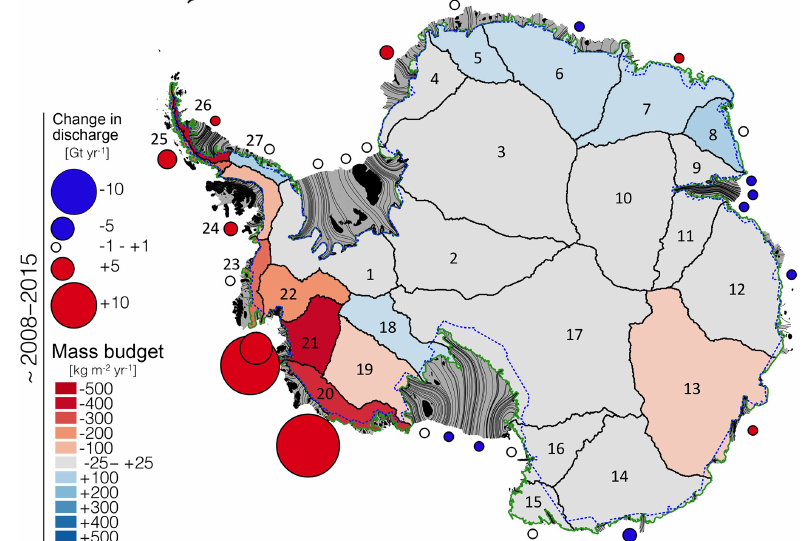
Figure 10. Mass budget and change in discharge for the 27 basins defined by Zwally et al. (2002). Mass budget is calculated as described in Table 2 using 2008–2015 average surface mass balance. Change in discharges (circles) calculated by differencing the pan-Antarctic SAR mapping of Rignot et al. (2011a; circa 2008) with weighted average of all 2015 image-pair displacements supplemented with 2009 SAR velocities to fill missing Landsat coverage poleward of 82.5 ◦ S (Scheuchl et al., 2012) with a correction for acquisition time differences to provide an estimate of total discharge for the interior basins (2, 17 and 18; see Table 2). Flux gates FG1 and FG2 are shown with solid green and dashed blue lines,